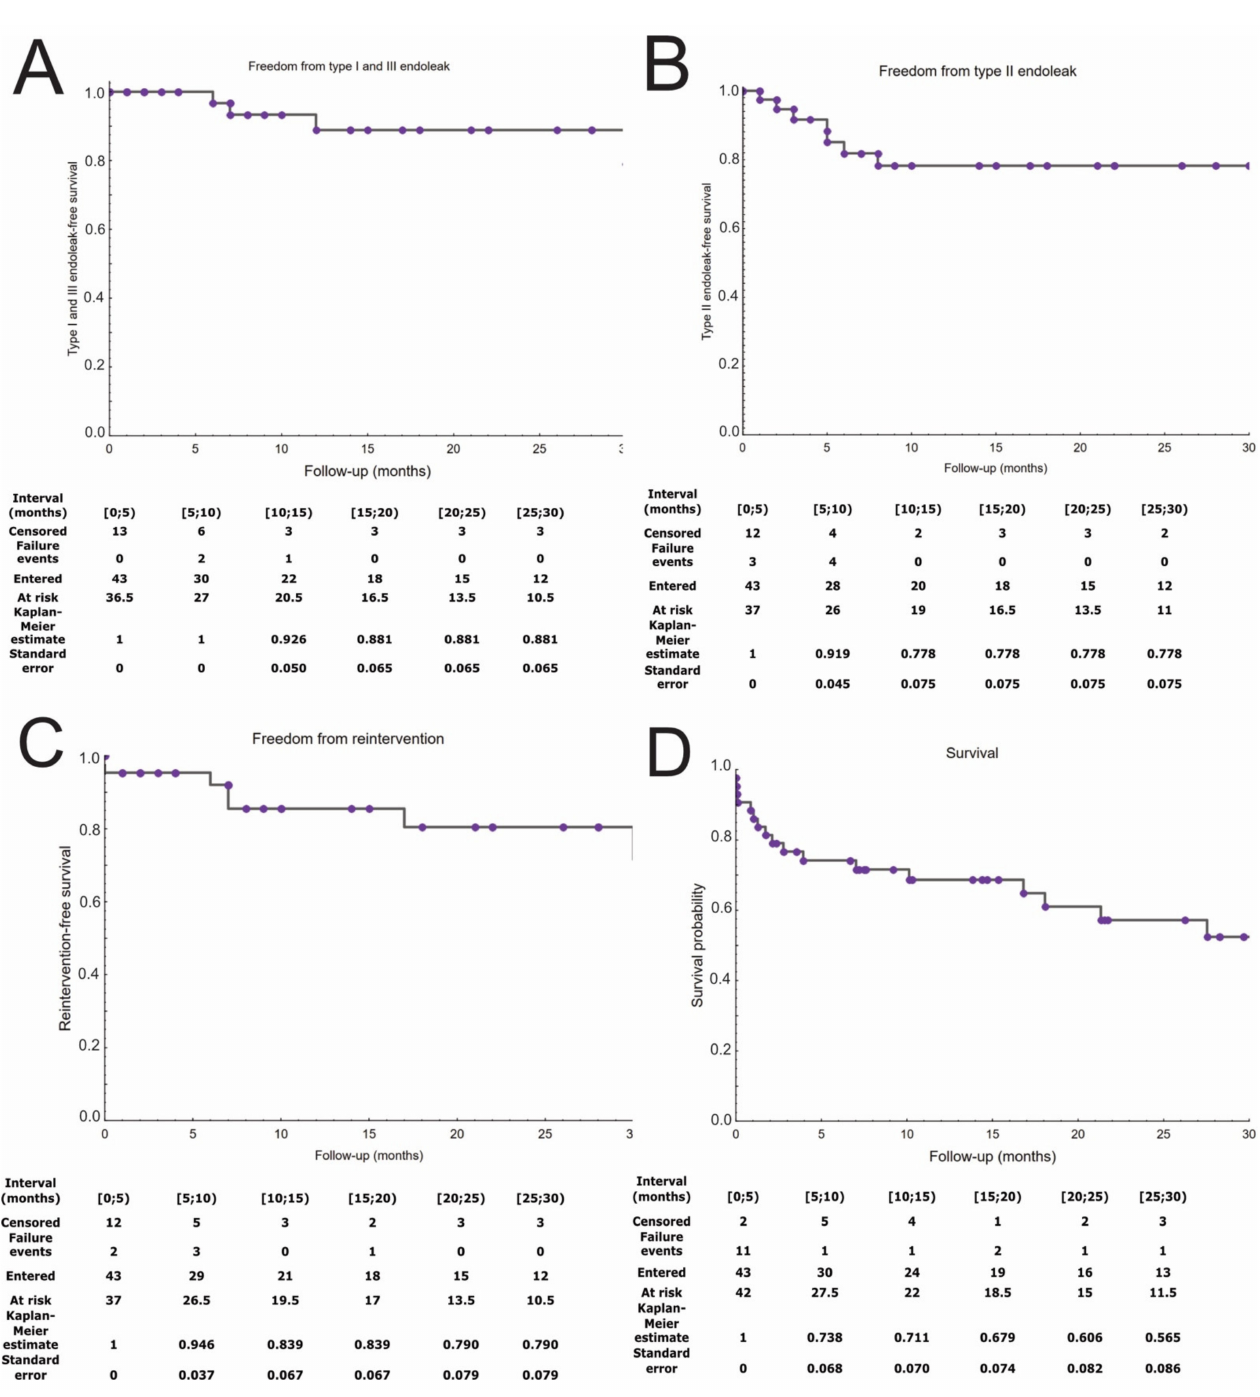
Figure 4. Clinical outcomes presented on Kaplan–Meier curves. Type I and III endoleak-free survival ( A ). Type II endoleak-free survival ( B ). Reintervention-free survival ( C ). Survival ( D